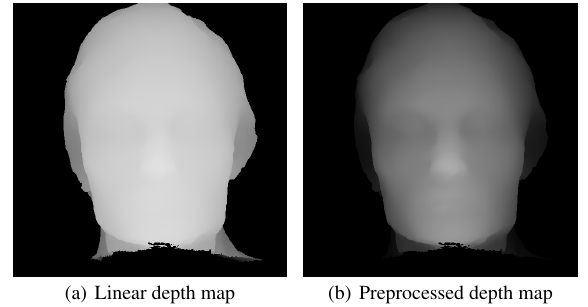
Figure 6. The preprocessing of depth maps